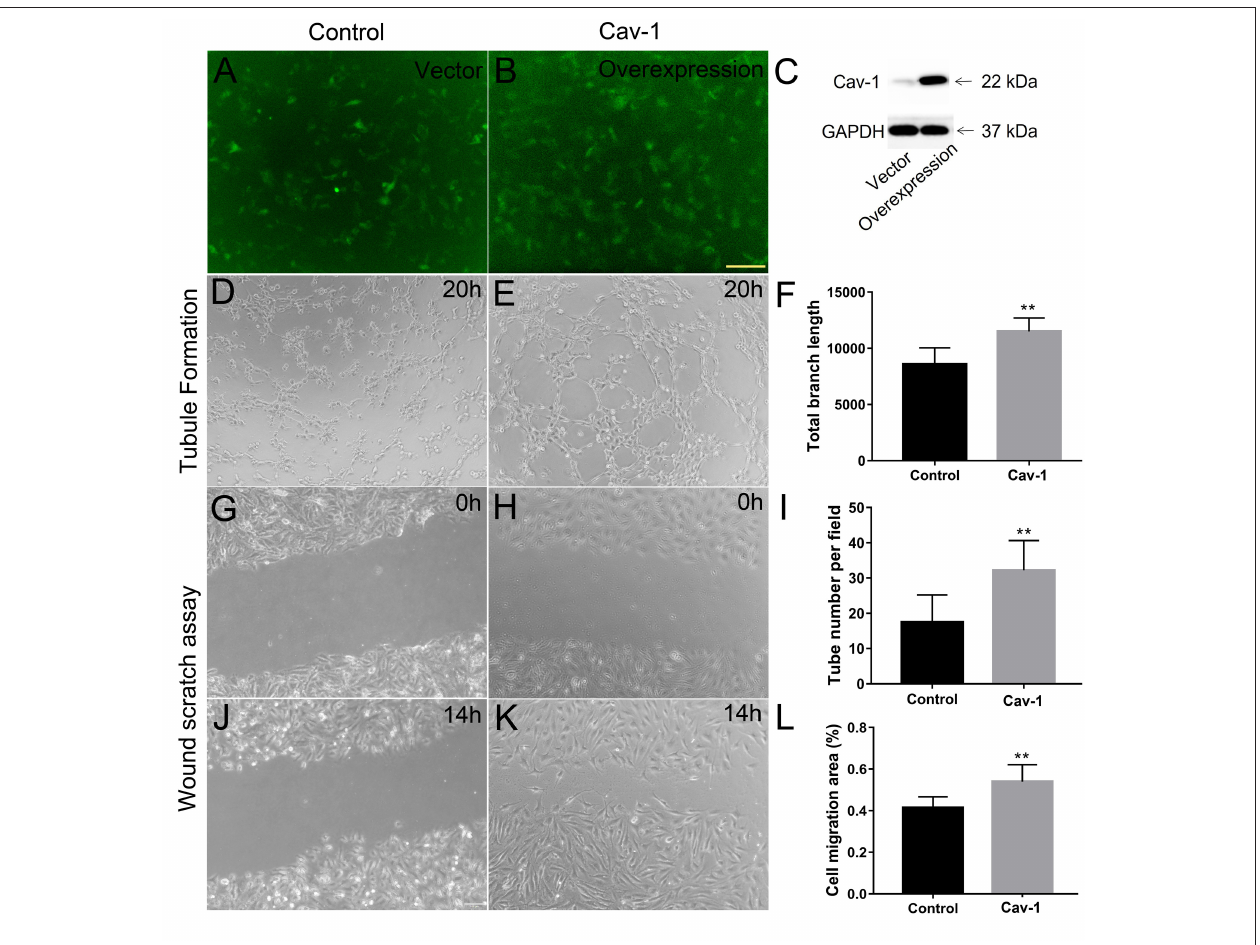
FIGURE 5 | Cav-1 overexpression promotes endothelial cell proliferation and capillary-like tube formation. The cultured human microvascular endothelial cells (HMECs) were dealt with empty vector (A) and Cav-1 overexpression plasmid vector (B) for 24h. before the following two assays (green signals represented successful transfection) and the enhanced expression of Cav-1 after transfection was confirmed by Western blotting (C) . The capillary-like tube formation assay (D,E) was evaluated at 20h after HMECs reseeded and the total branch length and tube numbers in per field were calculated (F,I) . Wound scratching assay of HEMCs was assessed at 0 (G,H) and 14h (J,K) after scratching by the 10 µ l pipette tip for both the groups. The residual area after scratching was calculated to evaluate the cell migration ability (L) . ** p < 0.01; scale bar = 100 µ